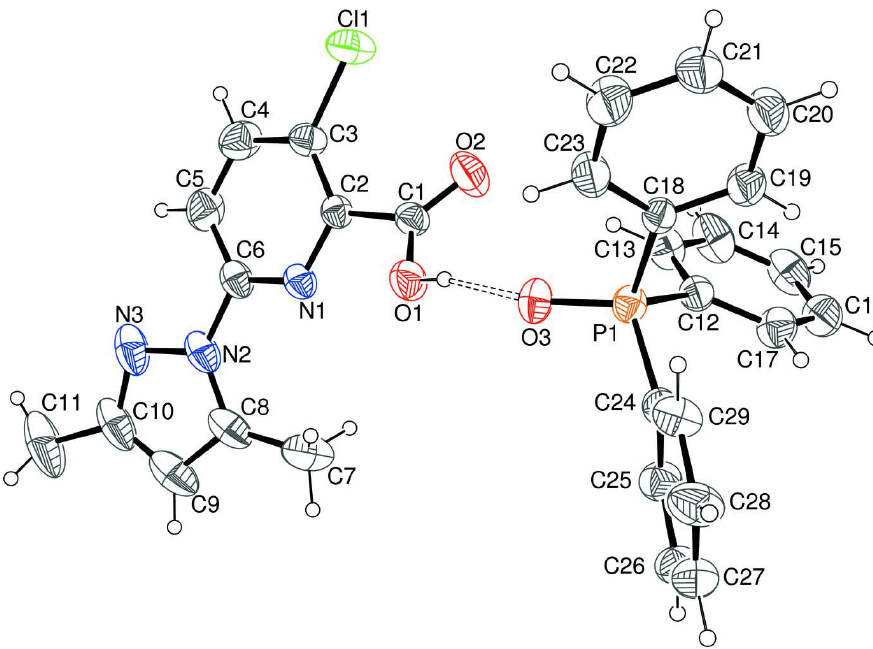
Figure 1 The molecular structure of (I) showing 30% probability displacement ellipsoids for the non-hydrogen atoms. The hydrogen bond is indicated by a double-dashed